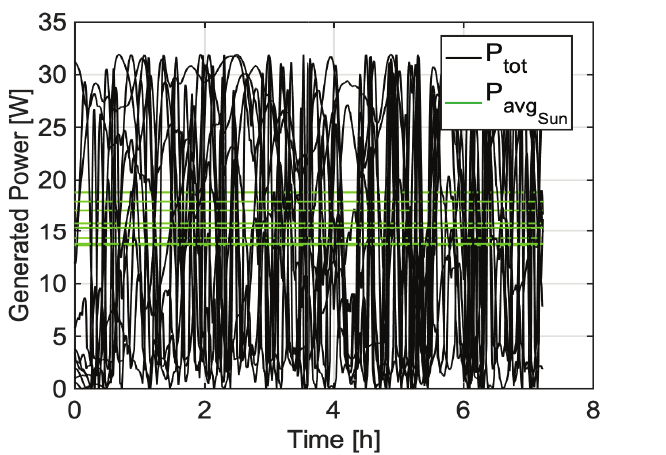
Figure 10. Solar arrays power Monte Carlo analysis, with no eclipses and magnetic actuators.